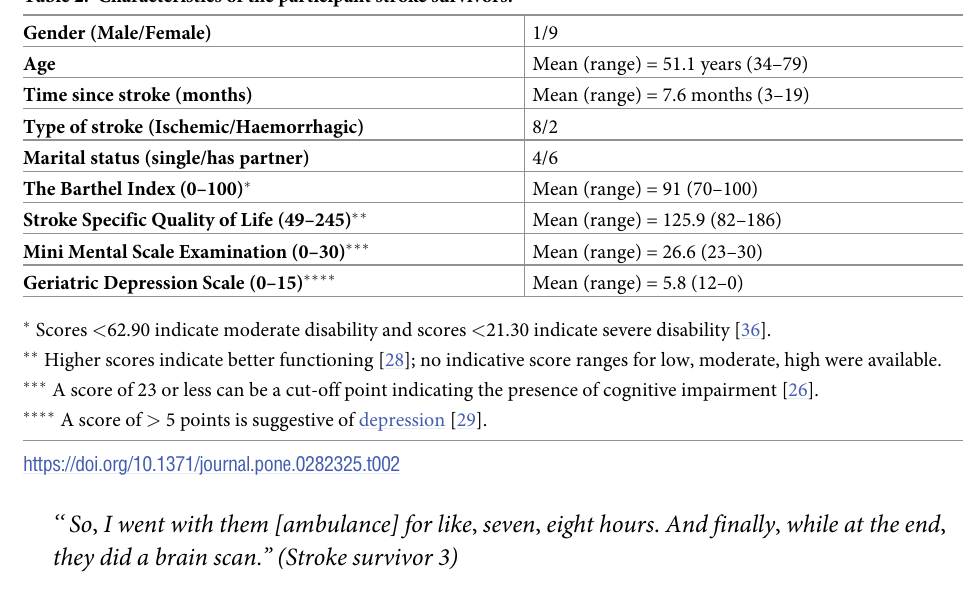
Table 2. Characteristics of the participant stroke survivors.